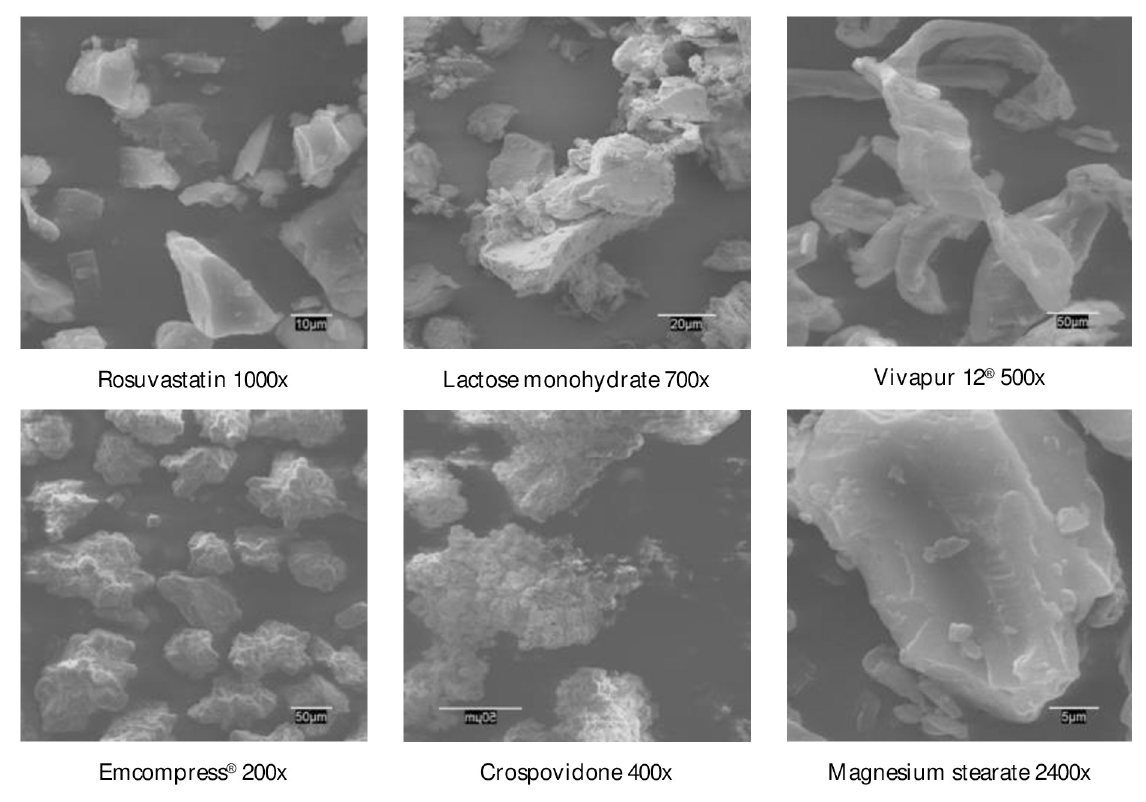
Fig 4. SEM of rosuvastatin calcium and selected